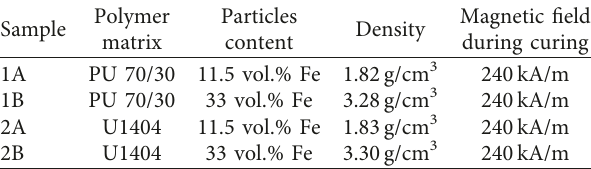
Table 1: Characterization of fabricated MRE